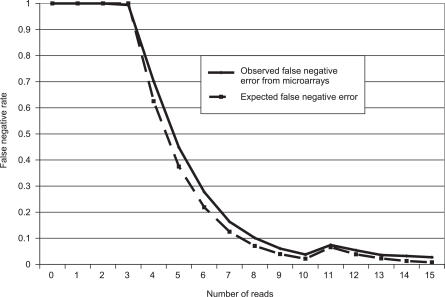
Modeling the Rate of SNP Detection from Microarray ExperimentsModel of the false-negative rate of heterozygous SNP detection found on Affymetrix or Illumina genotyping platforms in relation to the number of supporting reads found in the HuRef assembly at these loci. The observed false-negative rate of detected heterozygous SNPs in the HuRef assembly closely follows the modeled rate given a Poisson model. The predicted false-negative error is based on the thresholds of requiring at least 20% of the reads supporting the minor allele, two reads minimum. The increased false-negative error at 11 is due to the increased number of reads required to call the minor allele compared to two reads being required at 4×–10× coverage. Therefore, at 11×–15× coverage, three reads are required. The additional read changes the binomial distribution and increases false-negative error (See Materials and Methods).